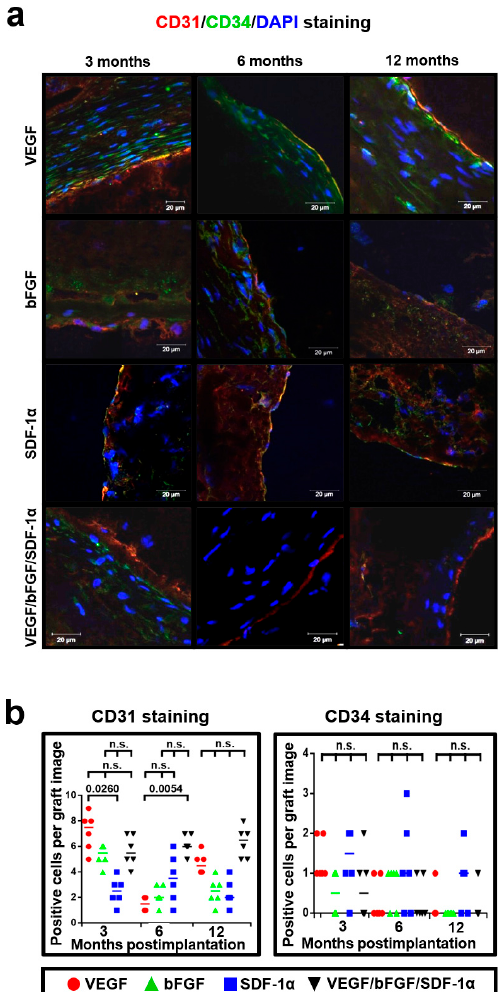
Figure 8. bFGF and SDF-1 α support VEGF-induced endothelialization of the luminal surface. ( a ) Representative images of CD31- (red), CD34- (green), and DAPI- (blue) stained grafts modified with either VEGF, bFGF, SDF-1 α , or all three factors at 3, 6, and 12 months postimplantation; ( b ) Quantitative image analysis, data are represented as a univariate scatterplot with the median, each dot represents a count from one image, Kruskal–Wallis test with the further Dunn’s multiple comparisons test, p values adjusted for multiple comparisons are reported in a numerical manner, n.s. is for not significant.